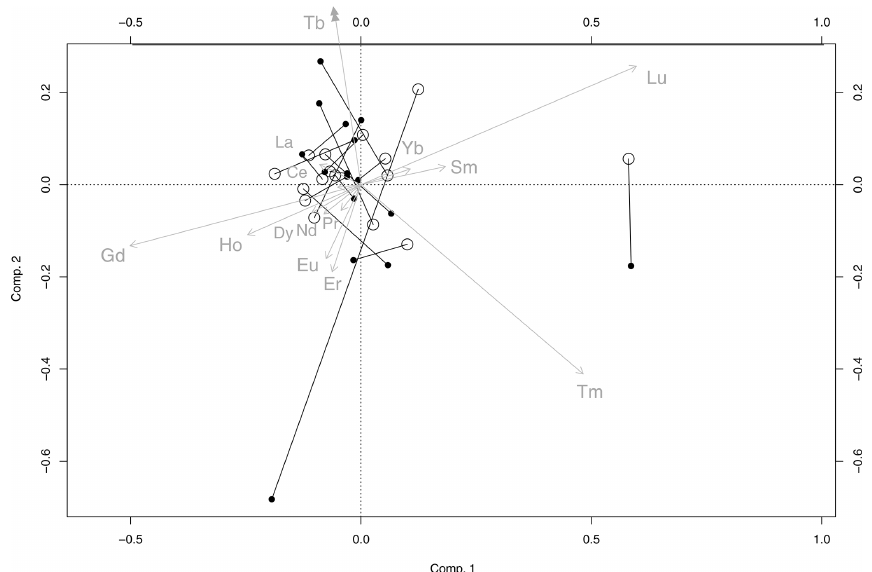
Figure 9. REE biplot for the two sampling devices. PM10 samples are figured with circles, and solid discs represent VTD samples. Lines between circles and discs link paired samples. Percentages of variability explained by the first two components are 29% and 22%, a total of 51%.